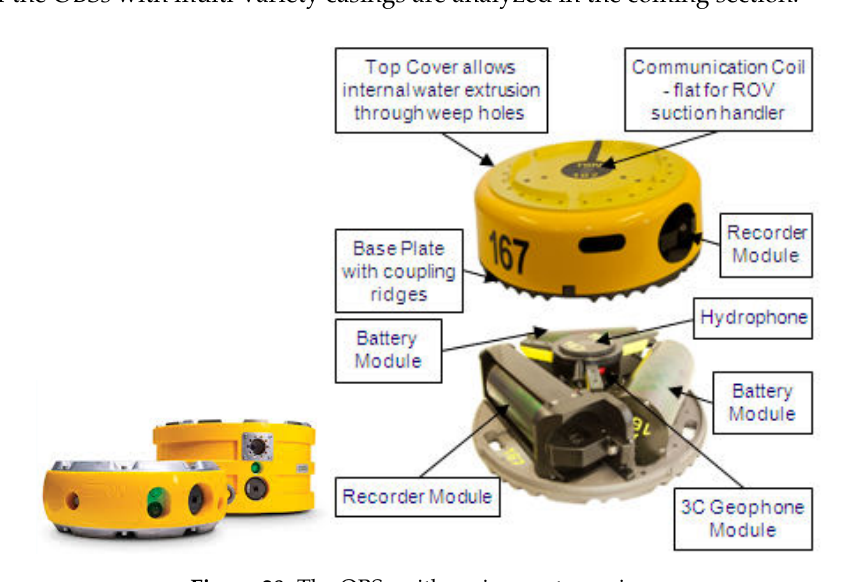
Figure 27. Vibration velocity amplitudes of the OBS with density gradients under incident angle of 90°.